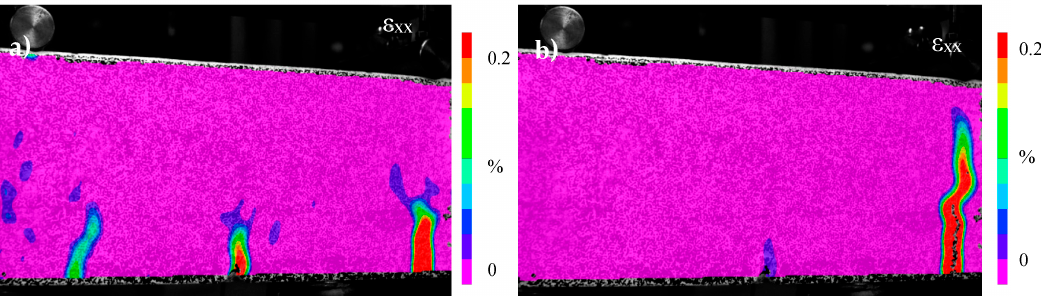
Figure 7. DIC strain ( ε xx ) profiles—Alumina piping system: ( a ) multiple cracks form; and ( b ) macro-crack formed at the 3D printed distribution piece.